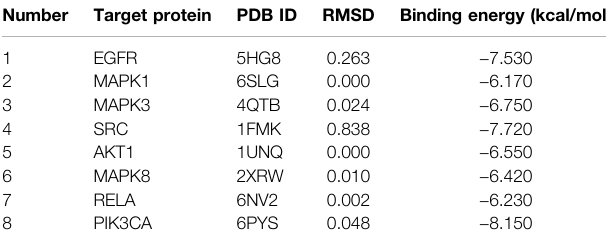
TABLE 2 | Molecular docking results of kaempferol with top eight critical